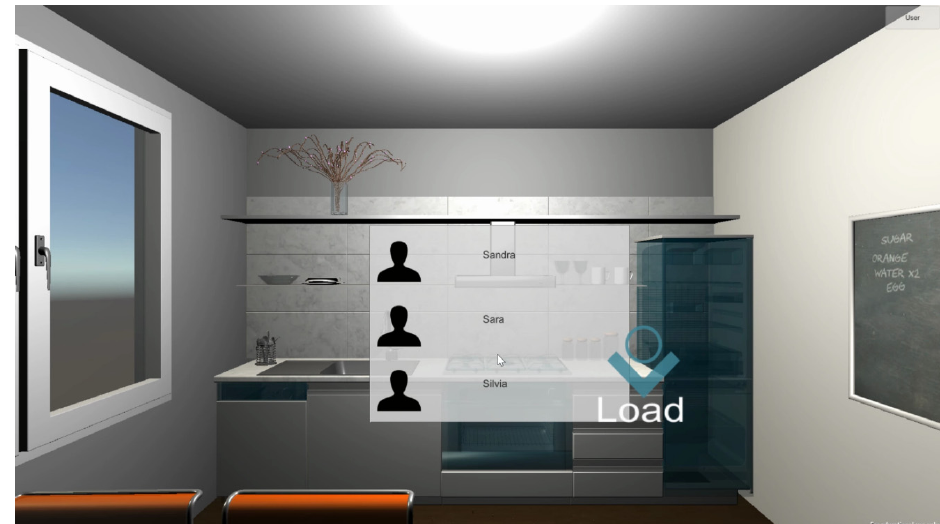
Figure 6. A snapshot of the RecALL: The designer selects the resident for which the reconfiguration project is executed. Once the resident is selected, SPARQL queries interrogate the knowledge base to retrieve the appliances suitable for the chosen resident, according to their health condition.